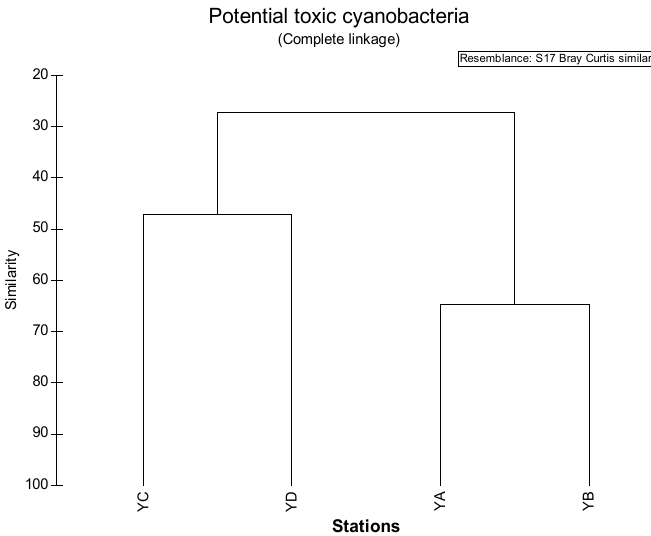
Figure 9. Cluster analysis of the sampling sites. Two clusters were formed: stations further away from the weirs (YA, YB) and stations near the weirs (YC, YD).